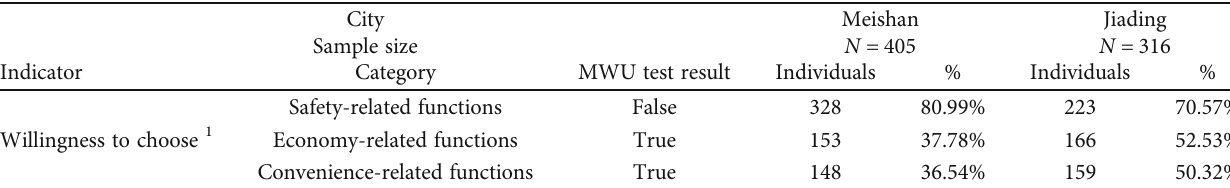
Table 5: Willingness to choose di ff erent ADAS or autonomous driving